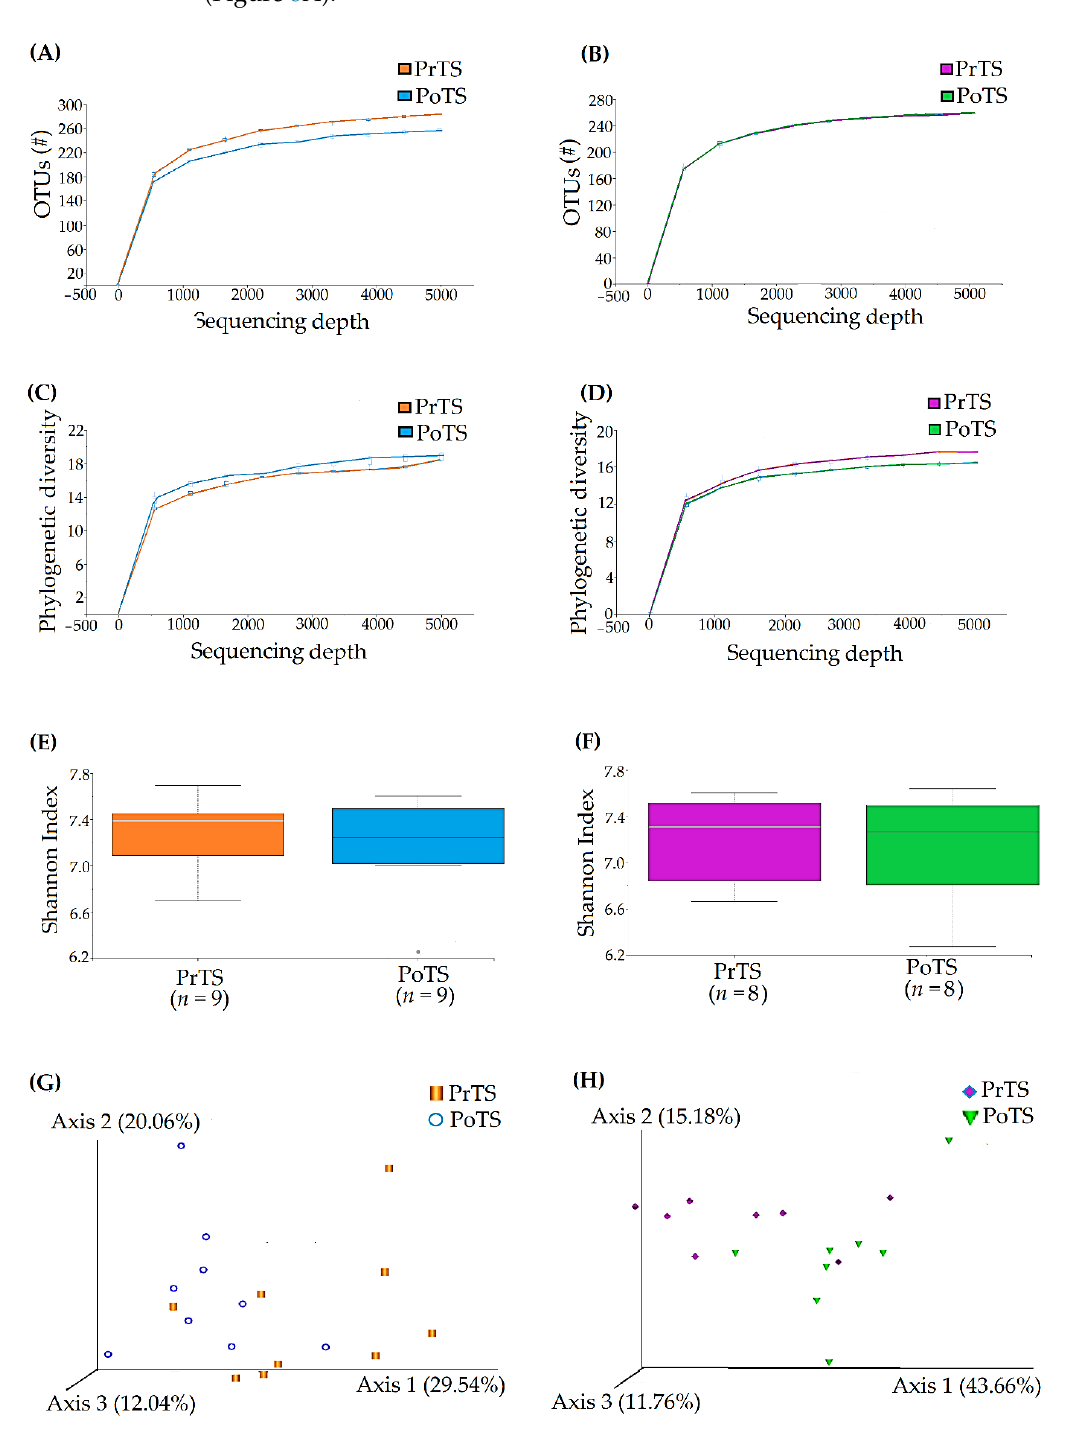
Figure 8. Refraction analysis for the G1 (PrTS and PoTS) and G2 (PrTS and PoTS) samples. The rarefaction curves of observed OTUs and the phylogenetic diversity were computed for G1 ( A , C ) and G2 ( B , D ). Shannon H-index alpha diversity of the G1 ( E ) and G2 ( F ) samples. The inter- and intragroup species differences of G1 ( G ) and G2 ( H ) samples were compared using PCoA.